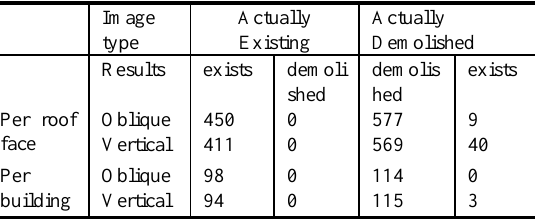
Table 1. Building verification results